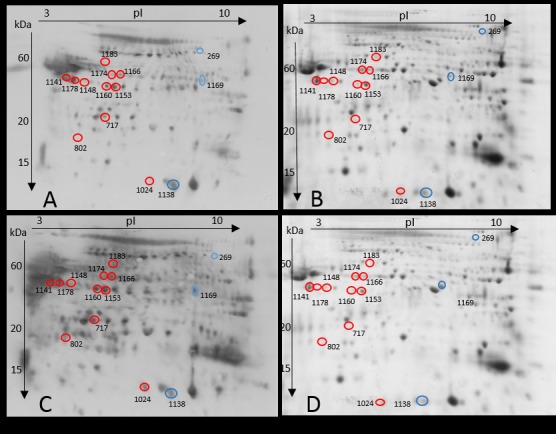
Representative two-dimensional (2D) gels and oxyblots of LQ and HQ ejaculates.2D oxyblot showing carbonylated proteins in HQ (A) and LQ ejaculates (C). 2D gel stained with Coomassie Brilliant Blue showing the total proteins in HQ (B) and LQ ejaculates (D). Differentially carbonylated protein spots are numbered and listed in Table 3. The protein spots marked in red indicate higher carbonylation in LQ ejaculates while protein spots marked in blue indicate higher carbonylation in HQ ejaculates.